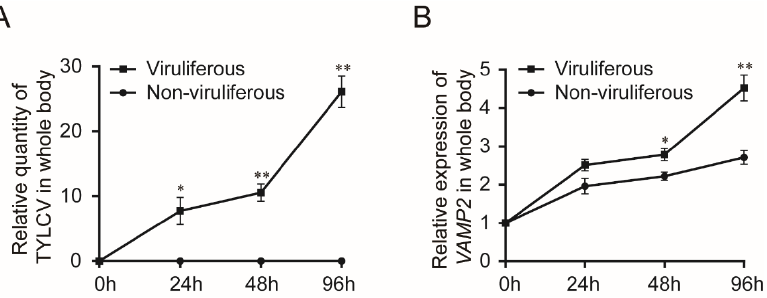
rabbit pAb was used to detect BtVAMP2 by Western blot. ( B ) GST pull-down analysis. GST-TYLCV